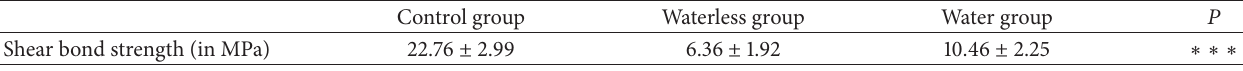
Table 1: Comparison of the mean data for the shear bond strengths and the standard deviations of the groups.